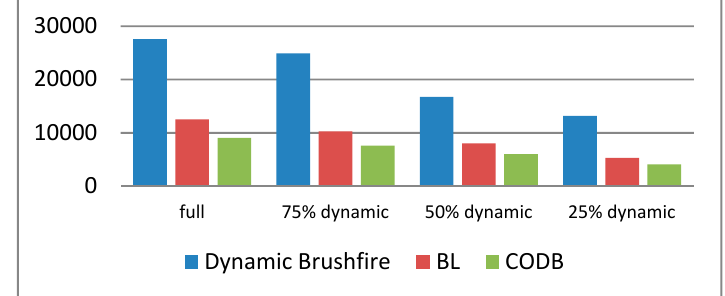
Figure 11. The average cell visits provided by the three dynamic algorithms.